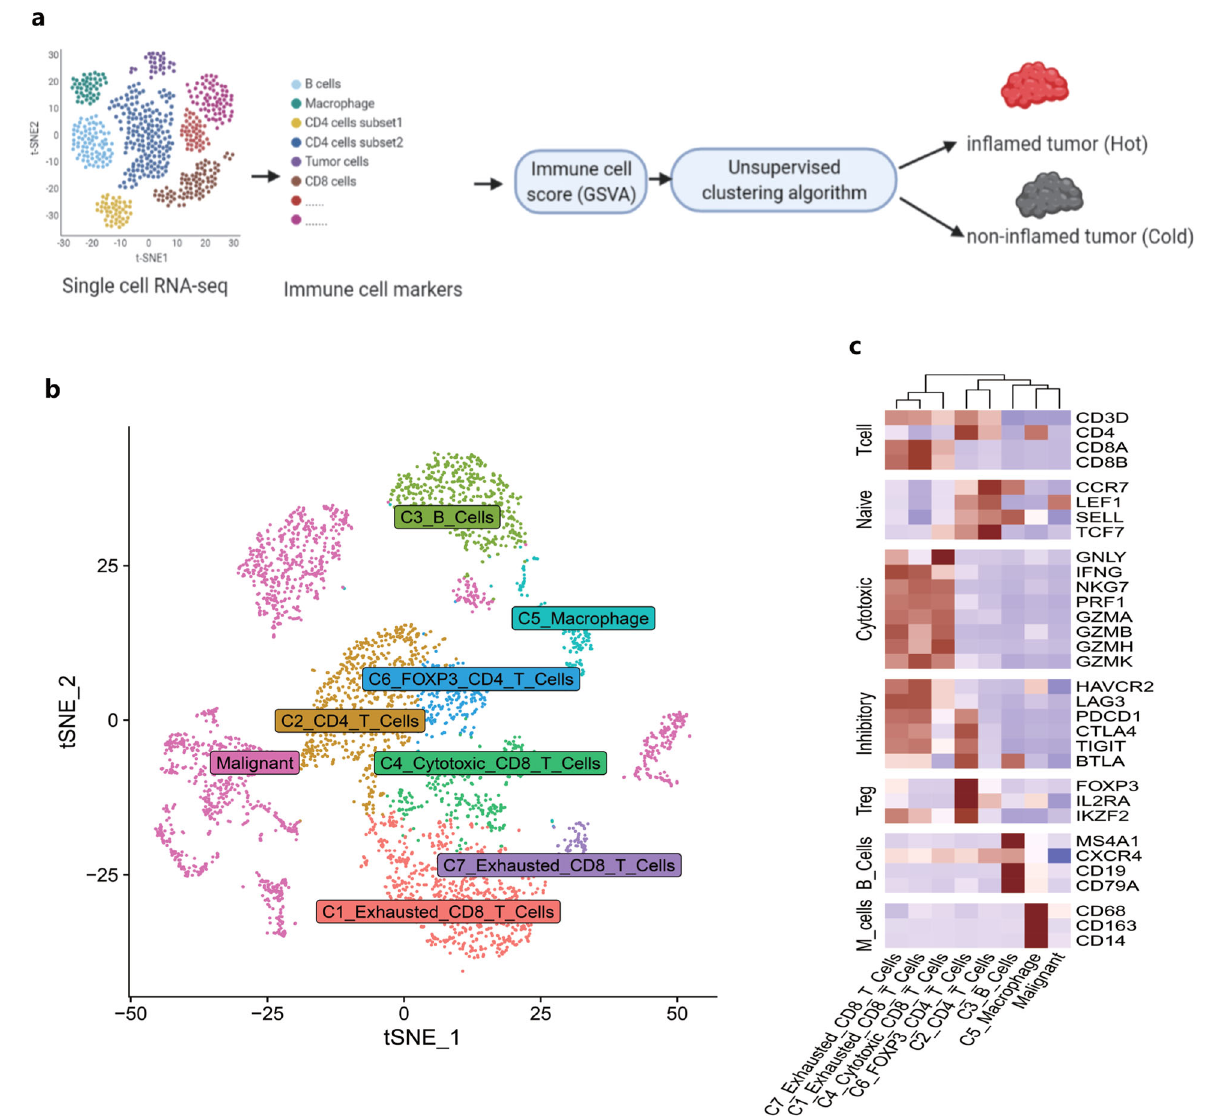
Fig. 1 Acquisition of immune cell signatures. a Overview of the work fl ow design. b tSNE dimension plot of cells in tumors. Each dot represents a cell colored and labeled by inferred cell types. c Heatmap for cell-type annotation in single-cell RNA sequencing. The color represents the mean expression (log2 (TPM + 1)) of molecular markers (red: high, blue: